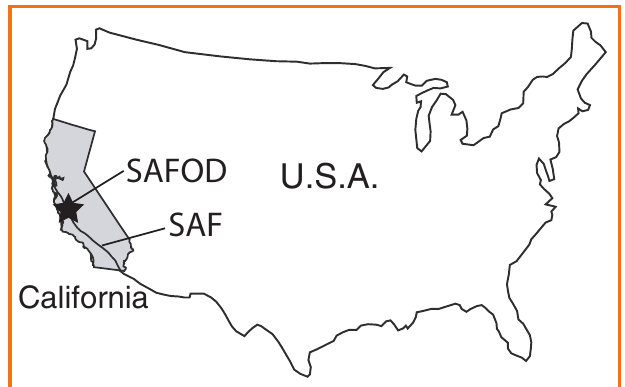
Figure 1. Location map of SAFOD. SAF denotes active surface trace of the San Andreas Fault.